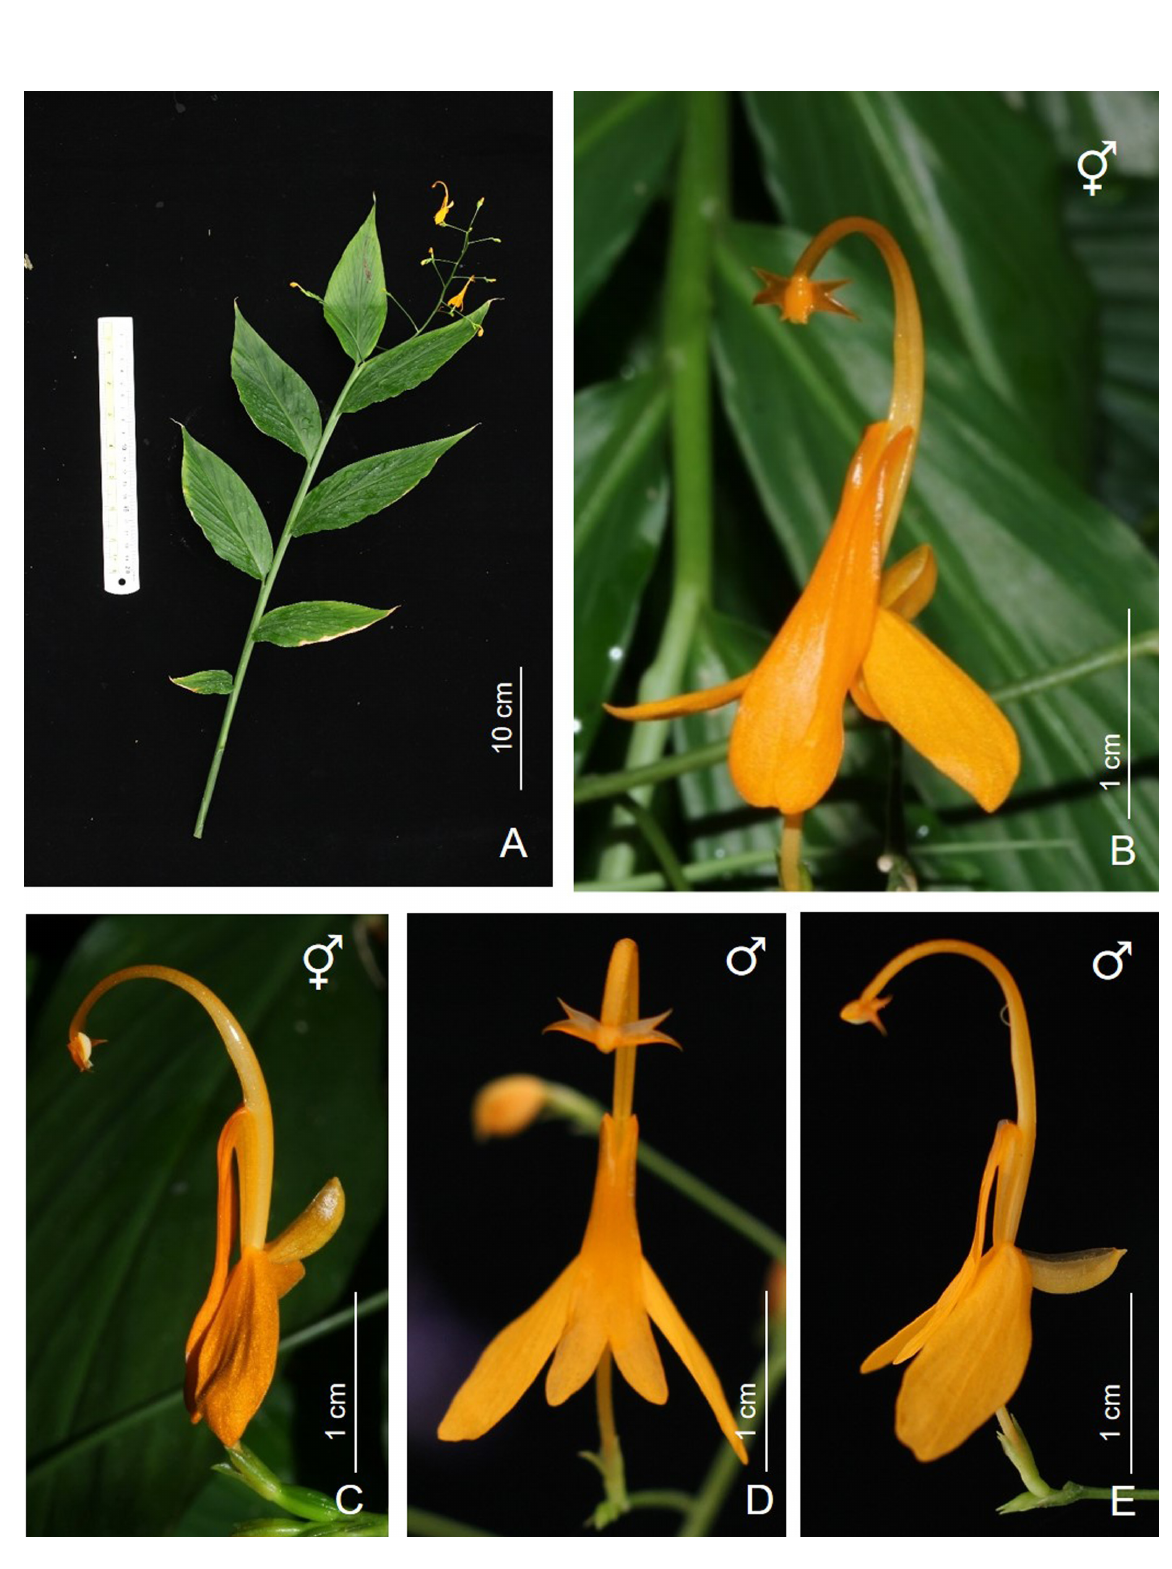
Fig. 14. Globba macrochila Sangvir. & M.F.Newman sp. nov. A . Habit. B . c Flower (front view). C . c flower (side view). D . ♂ flower (front view). E . ♂ flower (side view). Photographs: